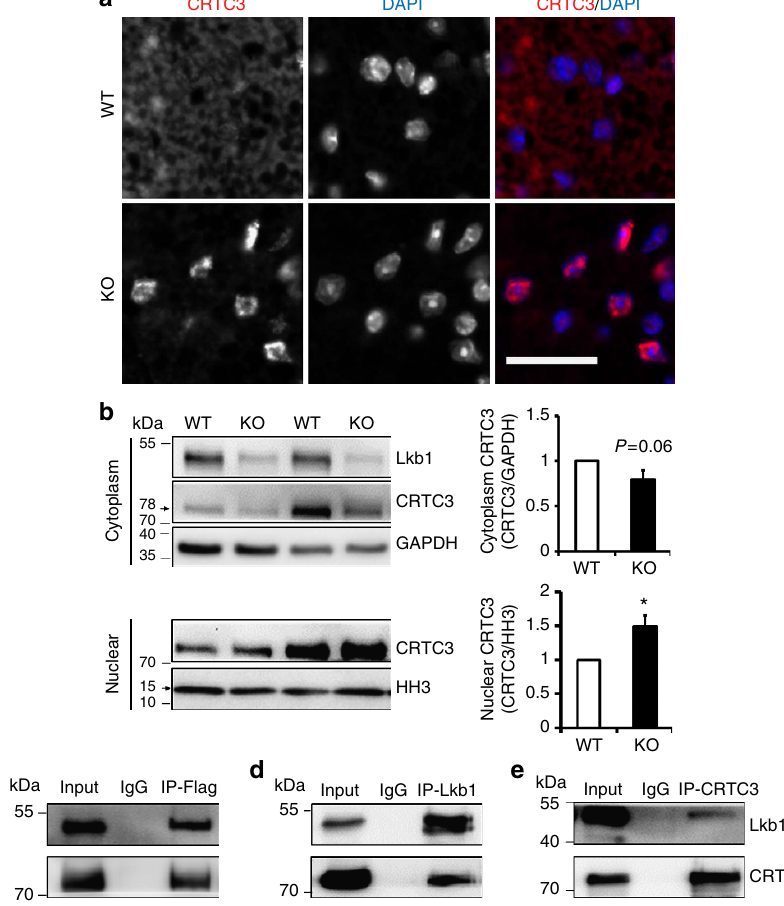
Figure 5 | Lkb1 interacts with CRTC3 to affect its nuclear translocation. ( a ) Localization of CRTC3 to the nucleus (labelled by DAPI) in BAT sections of Lkb1 KO ( Adipoq-Lkb1 ) but not WT ( Lkb1 flox/flox ) mice. Scale bars, 25 m m. ( b ) CRTC3 protein abundance in the cytoplasmic ( n ¼ 4) and nuclear fractions ( n ¼ 6) of BAT from WT and KO mice. Error bars represent s.e.m. * P o 0.05, two-tailed Student’s t -test. ( c – e ) Lkb1 interacts with CRTC3. 293Tcells were transfected with pCDNA-Flag-CRTC3 and the lysates were immunoprecipitated (IP) with Flag ( c ), Lkb1 ( d ) and CRTC3 ( e ) antibodies and blotted with Lkb1 and CRTC3